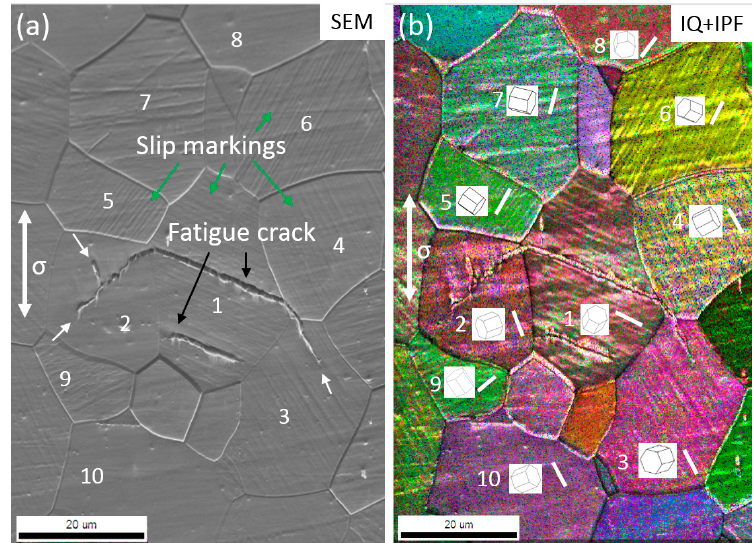
Figure 5. Color-coded orientation map at the fatigued specimen surface (130 MPa): ( a ) SEM image of specimen surface containing a fatigue crack and ( b ) grain orientation of the region in (a).